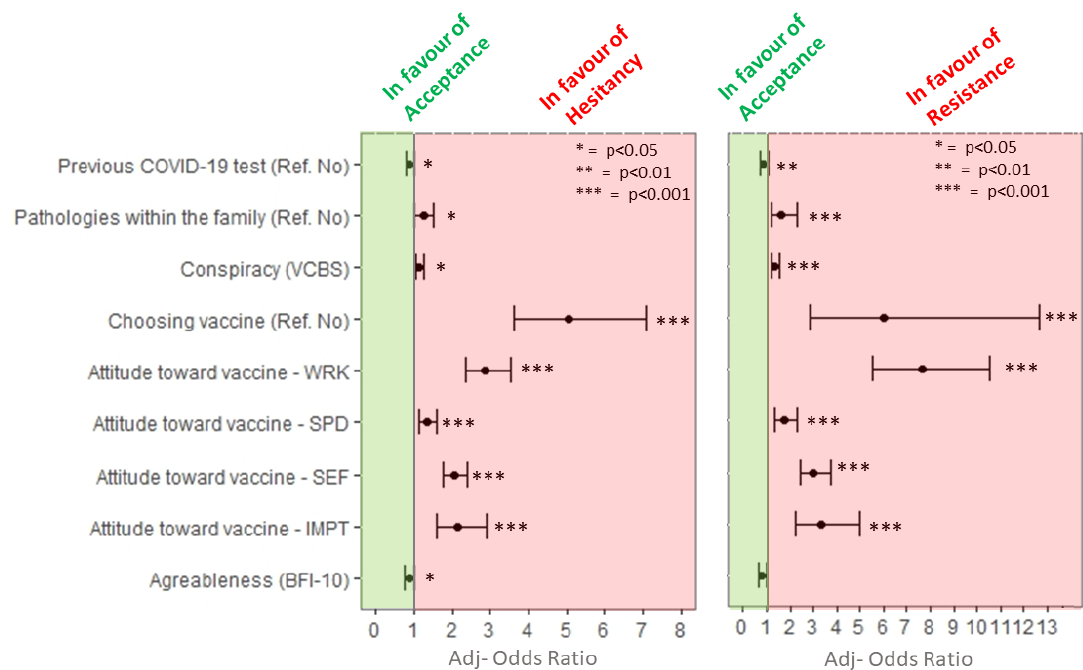
Figure 3. Multivariable analysis including variables statistically significantly associated with viral vector vaccine hesitancy. * p < 0.05; ** p < 0.01; *** p < 0.001. Table 3. Factors associated with mRNA and viral vector vaccines hesitancy.